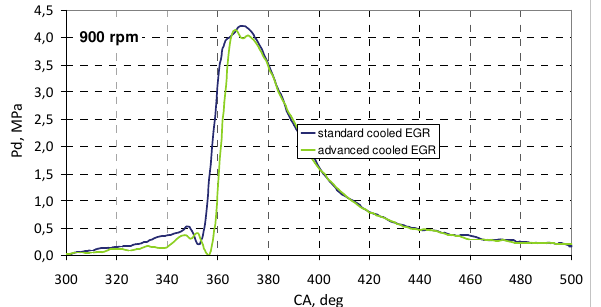
Fig. 22. Impact of EGR cooling system at MBF specific values (engine rotational speed: 900 rpm, 190 Nm load)